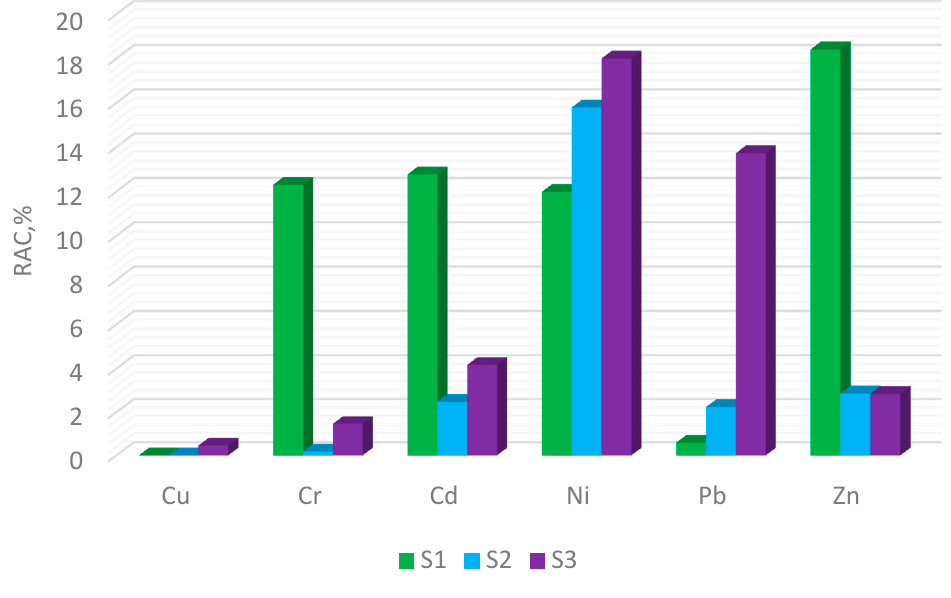
Figure 4. RAC of HMs in SS.